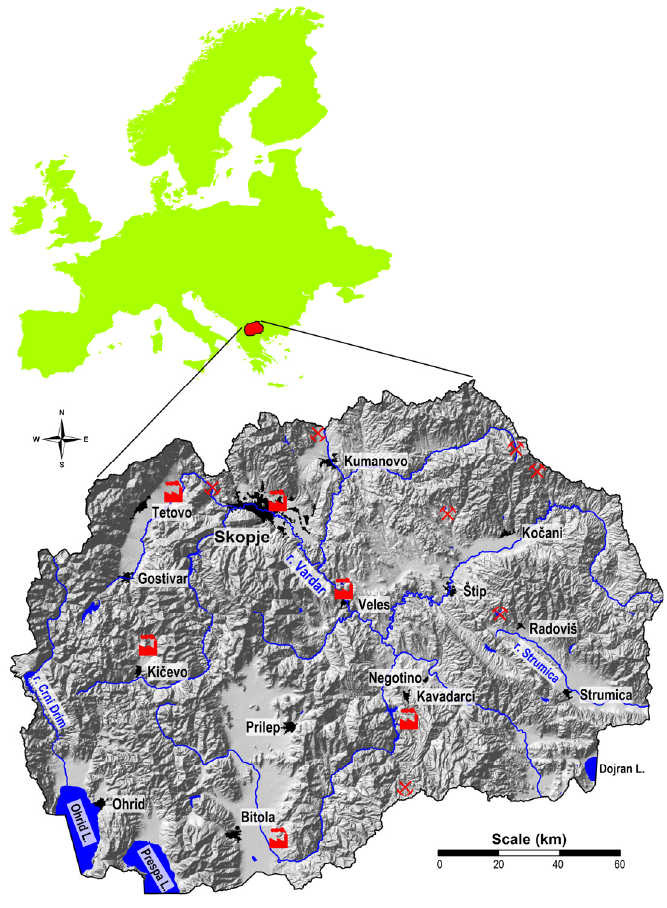
Figure 1. Map of the Republic of Macedonia.